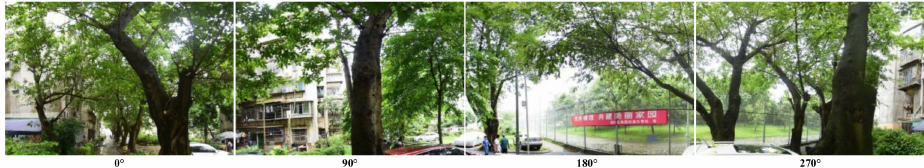
Figure 4. Example of a street view image in a given sample location from four